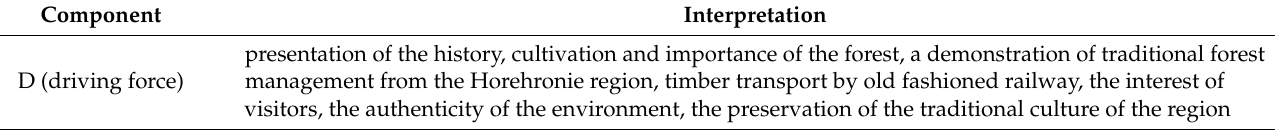
Table 5. DPSIR model for Č ierny Balog.